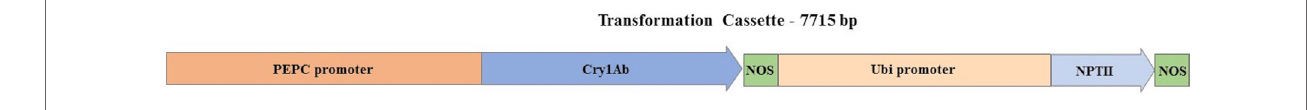
FigUre 2 | Transformation cassette used to obtain CTC175-A event via biolistic transformation of CTC20 sugarcane